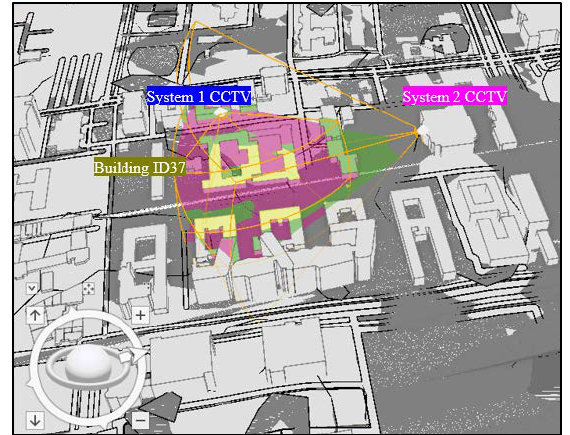
Figure 6. multiple CCTV systems coverage